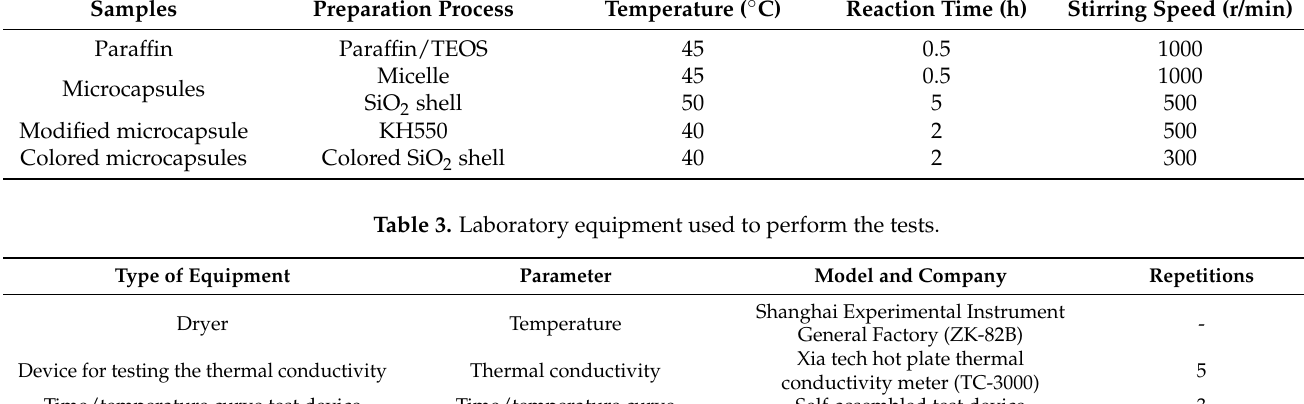
Table 3. Laboratory equipment used to perform the tests.